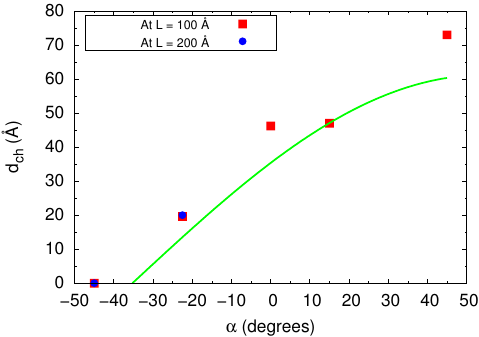
Figure 6. Chip thickness, d ch , as a function of the rake angle α . Simulation results (squares) are compared to the theoretical prediction, Equation (4). For the negative rake angles, data were also obtained for a cutting length of 200 Å (circles); see Appendix